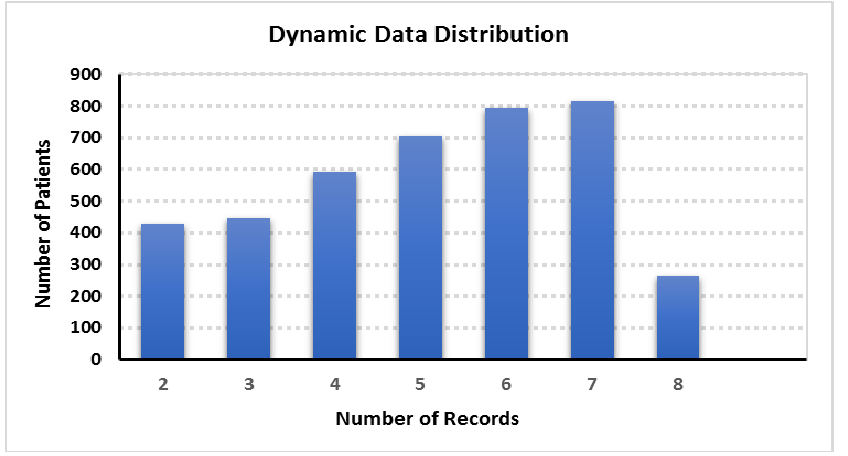
Figure 9. Dataset 2: dynamic data distribution.